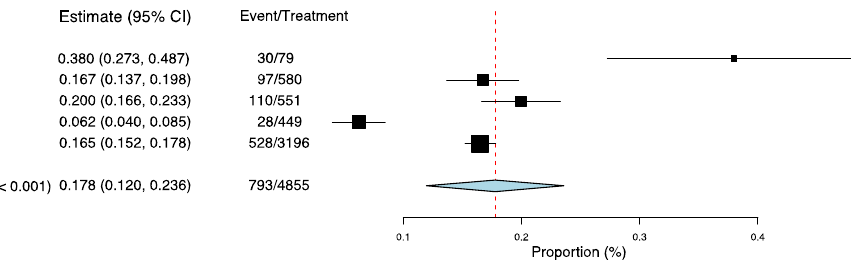
Figure 3. Incidence rate of allergic conjunctivitis among individuals with dry eye. Abbreviation: 95% CI: 95% confidence interval [19–22,26].